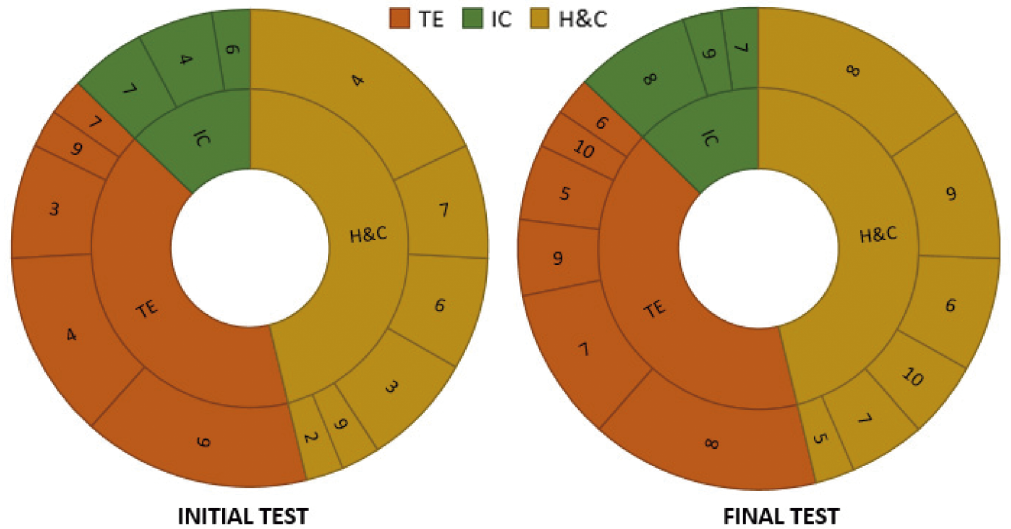
Figure 10. Marks obtained by the laboratory groups at the initial and final